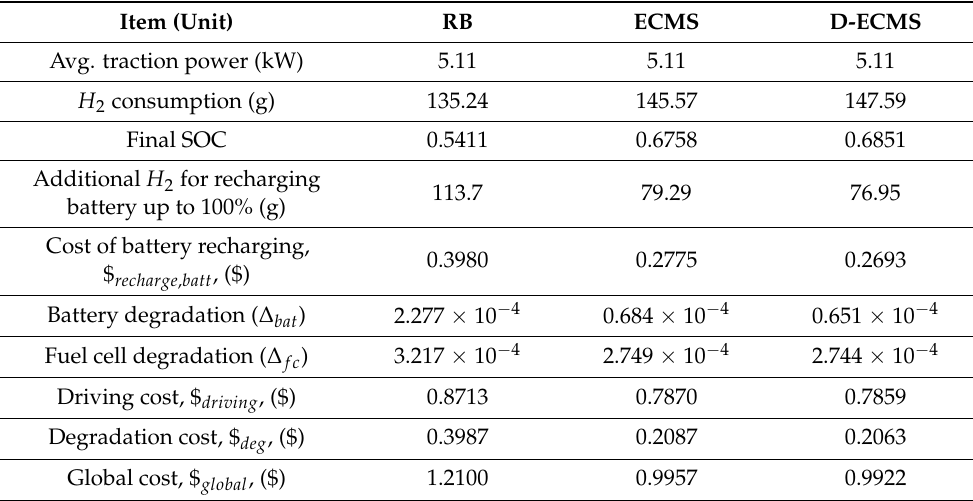
Table 4. Comparison of RB, ECMS, and D-ECMS on FTP-72 driving cycle. Item